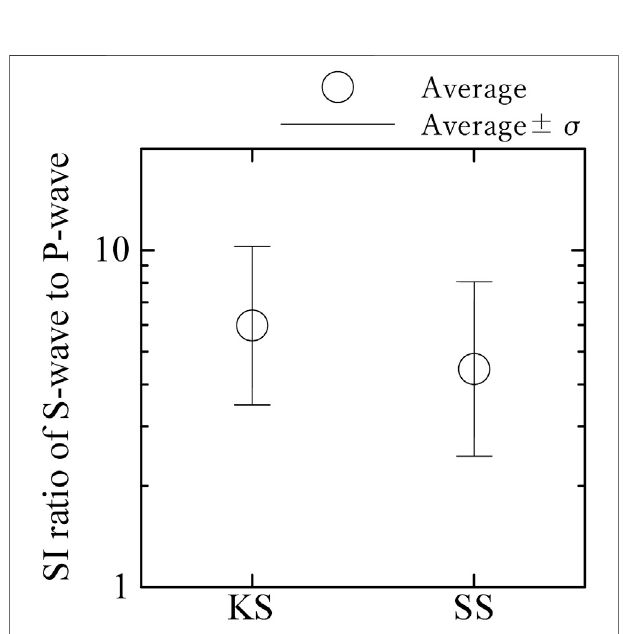
Frontiers in Earth Science |